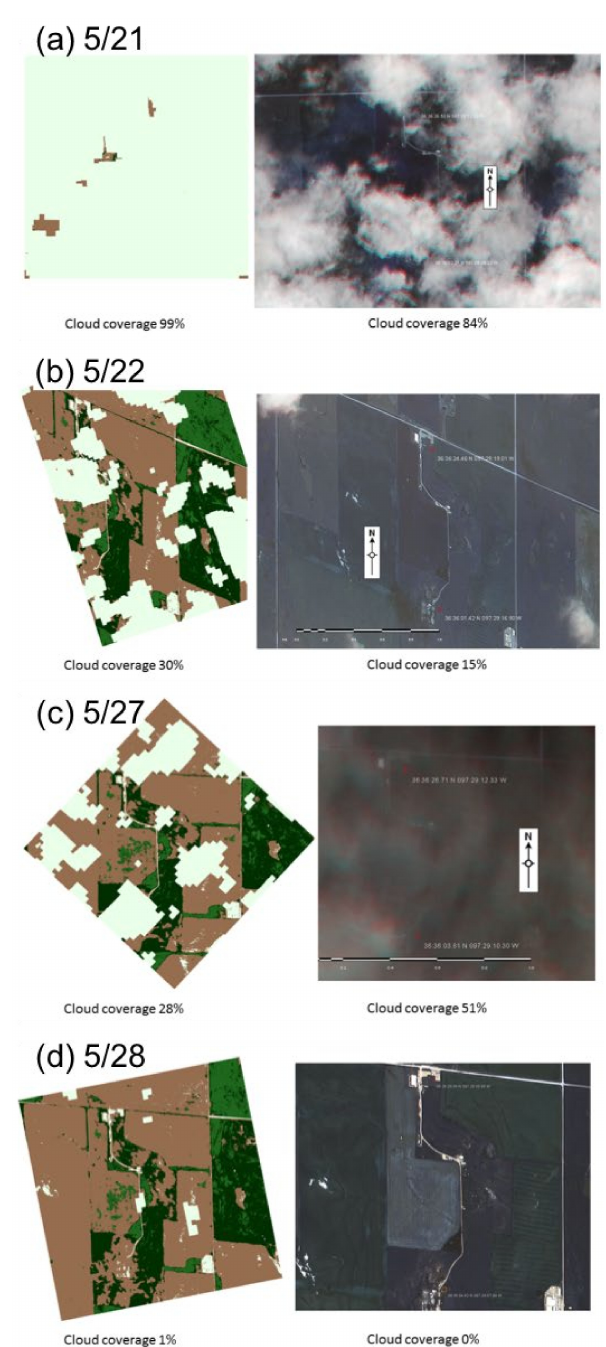
Figure 5. DIRSIG simulation with cloud mask from high-resolution atmospheric model ( left ), and WorldView-3 images ( right ) for ( a ) 21 May, ( b ) 22 May, ( c ); 27 May, and ( d ) 28 May. The left panels are rotated to align with the satellite images on the